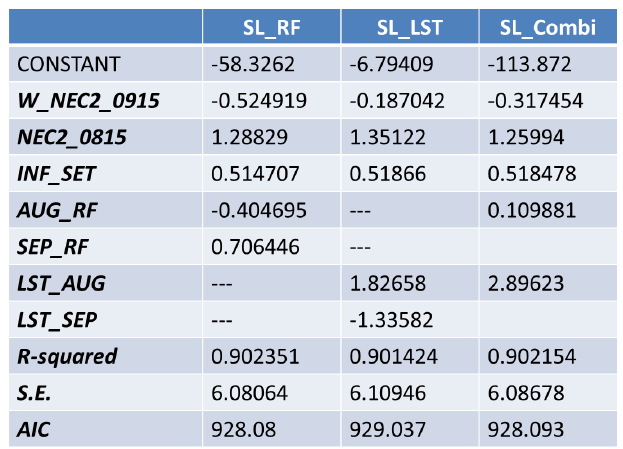
Table 3. SL Models for September 2015 (high dengue case) using meteorological